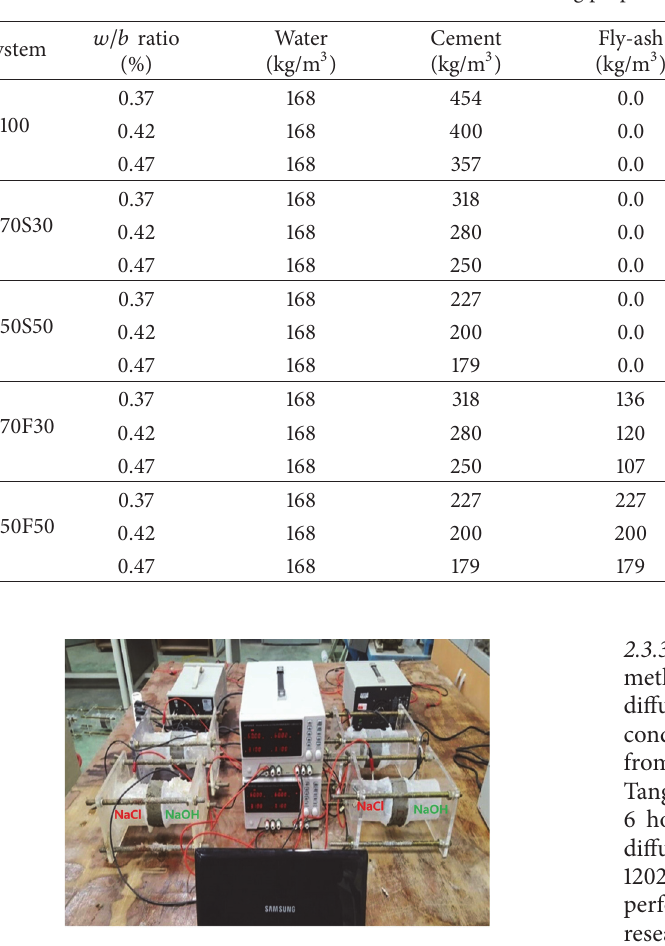
Figure 1: The photograph image of RCPT experiment